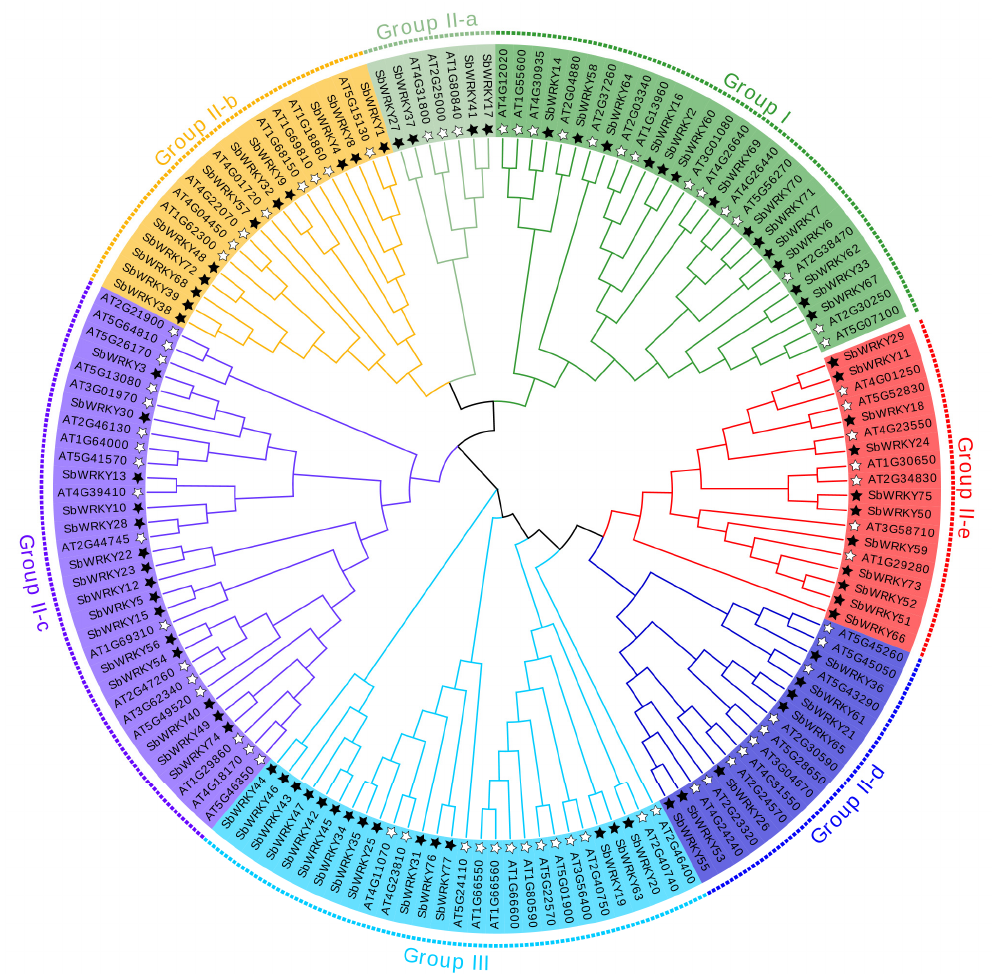
Figure 3. Comparative phylogenetic tree showed the domains relationship of SbWRKYs and AtWRKYs. The unrooted neighbor-joining (NJ) tree was constructed based on the amino acid sequences of WRKYs from S. baicalensis (77) and Arabidopsis (72) using MEGA-X with 1000 bootstrap replicates. The name of groups (Group I, Group II (Group II-a–Group II-e) and Group III) are shown outside of the circle, indicating different WRKY subgroups. Black star refers to SbWRKYs and white star refers to the AtWRKYs .